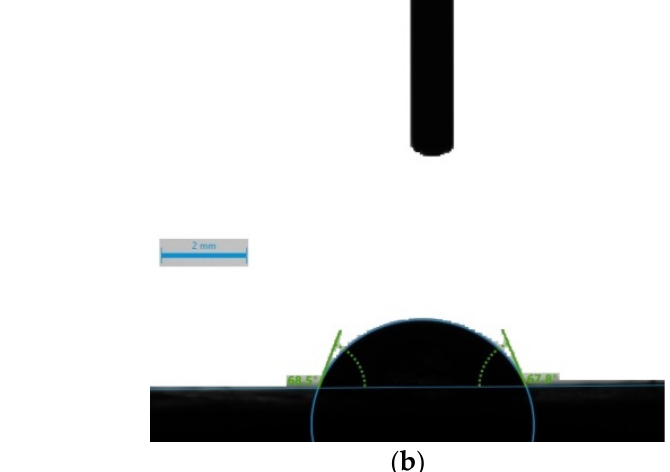
Figure 9. Water contact angles of raw leather ( a ) and leather modified by PEI ‐ Ag Nps solution ( b ).